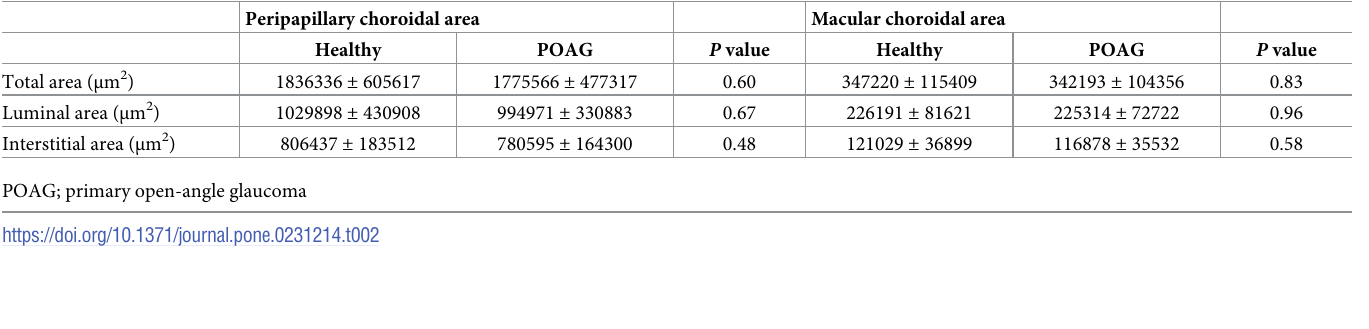
Table 2. Choroidal area observed in EDI-OCT